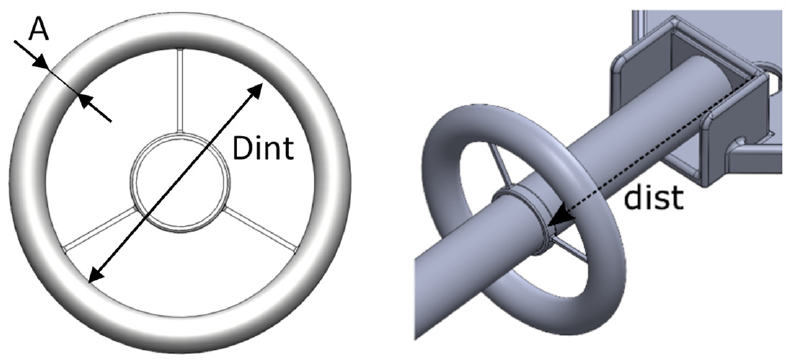
Figure 4. Design of individual rings installed around the conductors.